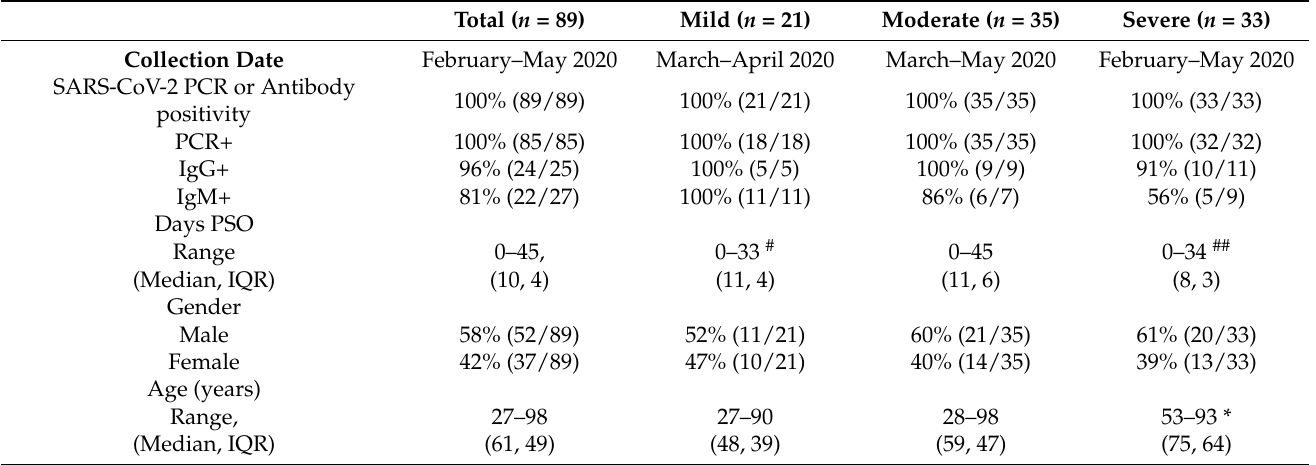
Table 1. Description of acute COVID-19 donor